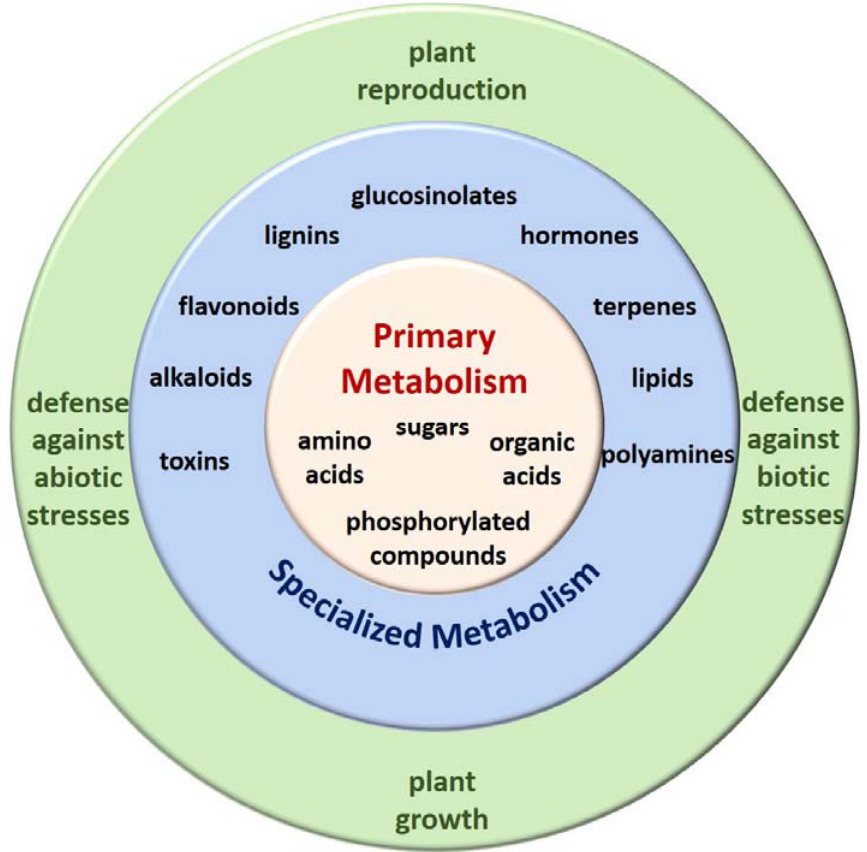
Figure 1. Plant metabolism. Primary metabolism (yellow) revolves around critical physiological compounds such as amino acids and sugars. Secondary metabolism (blue) utilizes central metabolites as building blocks for the biosynthesis of specialized compounds such as flavonoids, toxins, and lipids that have various functions (green), including plant growth and defense against stresses.